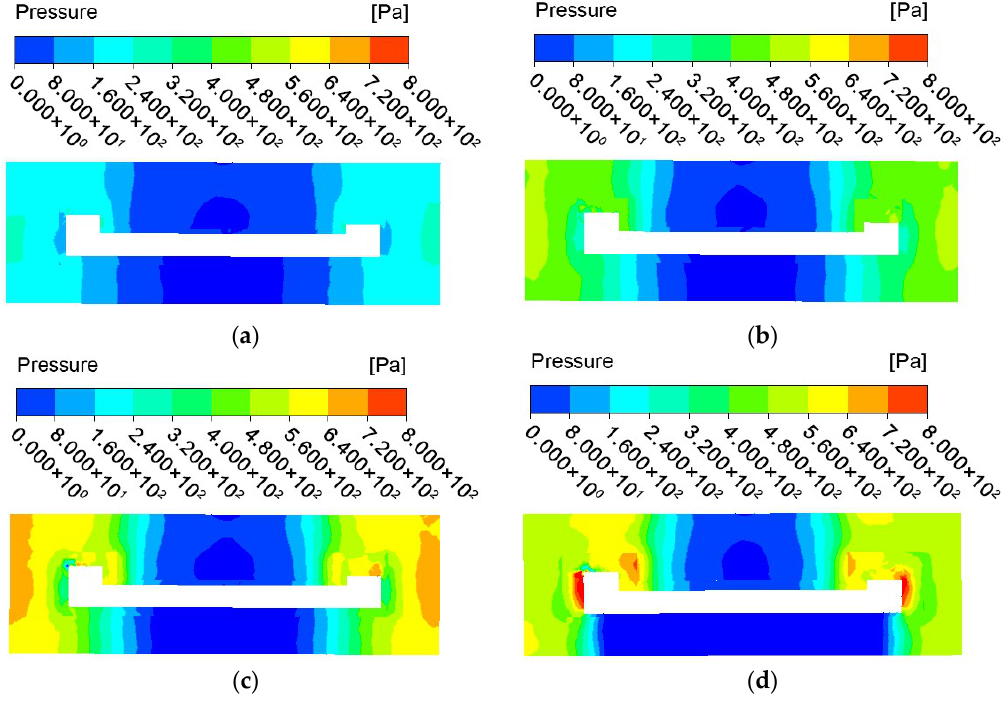
Figure 16. Static pressure contours on Section 1 under di ff erent values of c 3 : ( a ) 2.5 mm; ( b ) 5 mm; ( c ) 7.5 mm; ( d ) 10 mm.